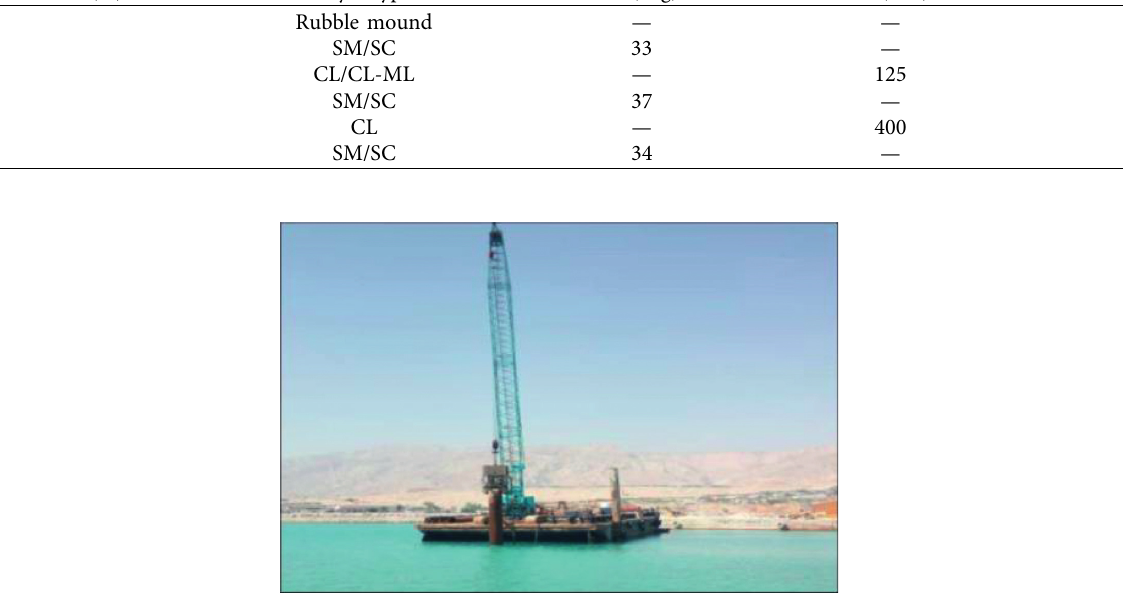
Figure 22: View of the piling at the docks of Tombak port.